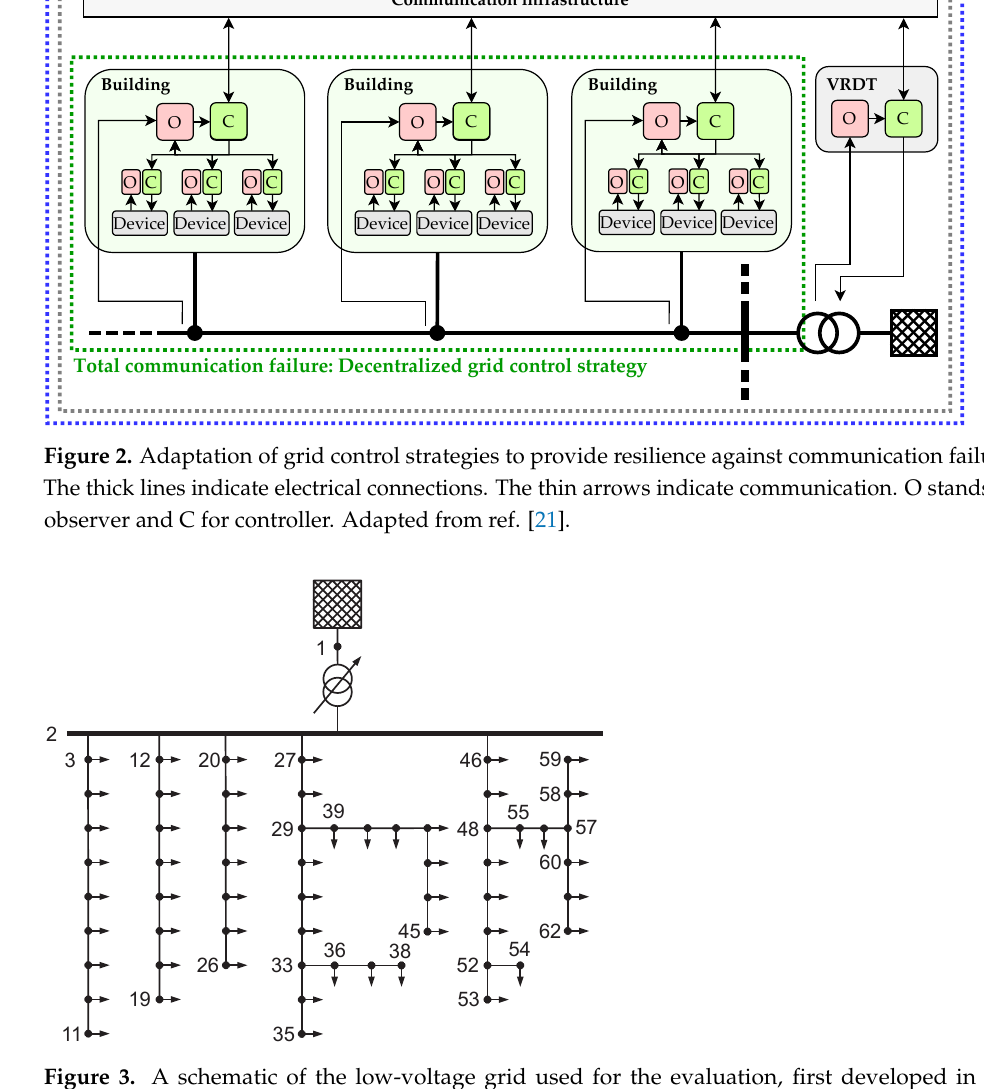
Figure 3. A schematic of the low-voltage grid used for the evaluation, first developed in [26]. Reproduced from ref.